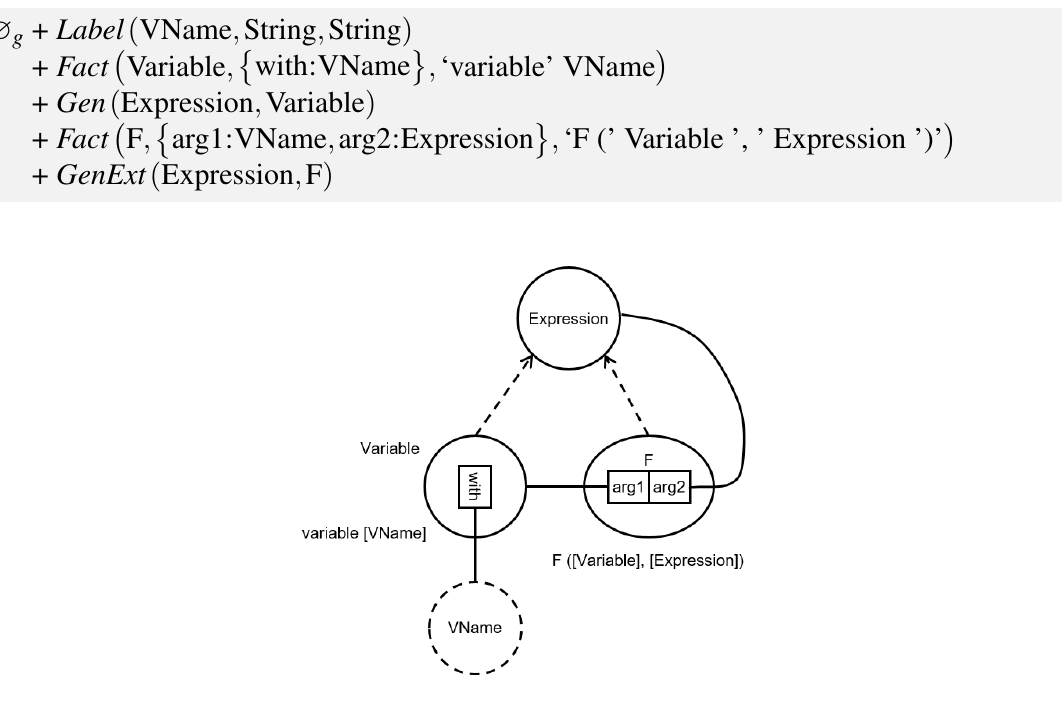
Figure 11. Construction of simple expressions